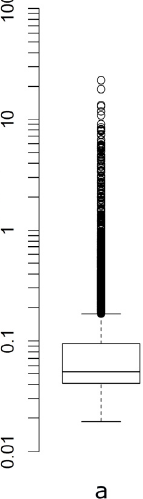
Figure 6. ( a ) Boxplot of all SPM concentration (SPMC) data from all CTD-Seapoints from both BoBo (measured at 2.5 mab) and DOS (measured at 1 mab) landers; ( b ) the RCM-derived SPMC (measured at 1 mab) during the station #45_EBS-2 experiment. Data from the EBS Seapoint (with small FNU range) are not shown because that sensor was often saturated.